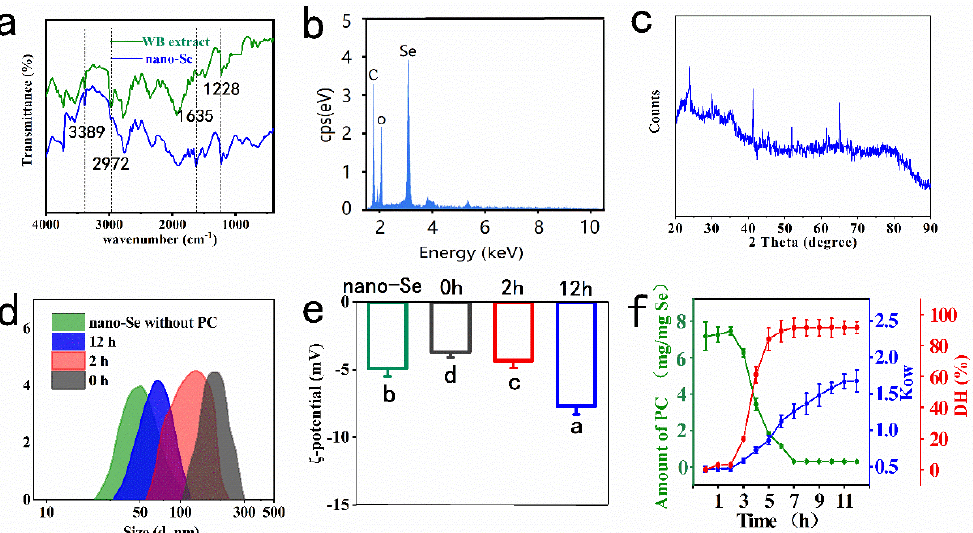
Figure 1. ( a ) FTIR spectra, ( b ) EDS spectra, and ( c ) XRD spectra of the prepared nano-Se. ( d ) Changes of average hydrodynamic diameters and ( e ) ζ -potential of during PC proteolysis using CFPE. ( f ) Changes in the PC amount on the surface of nano-Se and surface hydrophobicity with the increase in proteolysis time. Error bars represent the standard deviation (n = 6). Different alphabetic letters indicate significant difference ( p < 0.05).